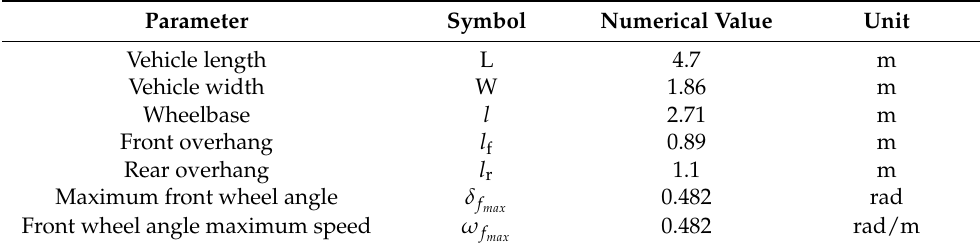
Table 1. Vehicle structure parameters.